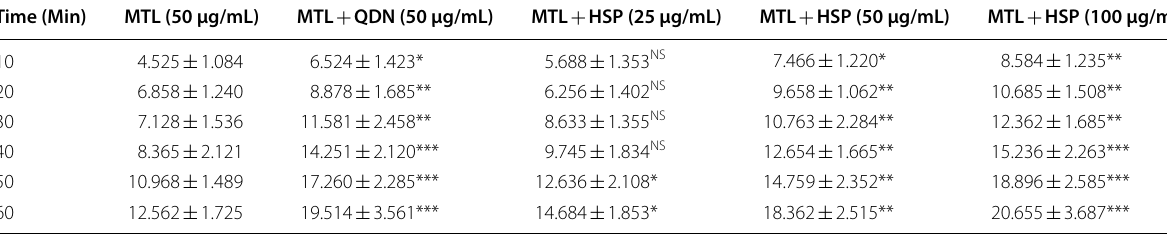
MTL , metoprolol; QDN , quinidine; and HSP ,